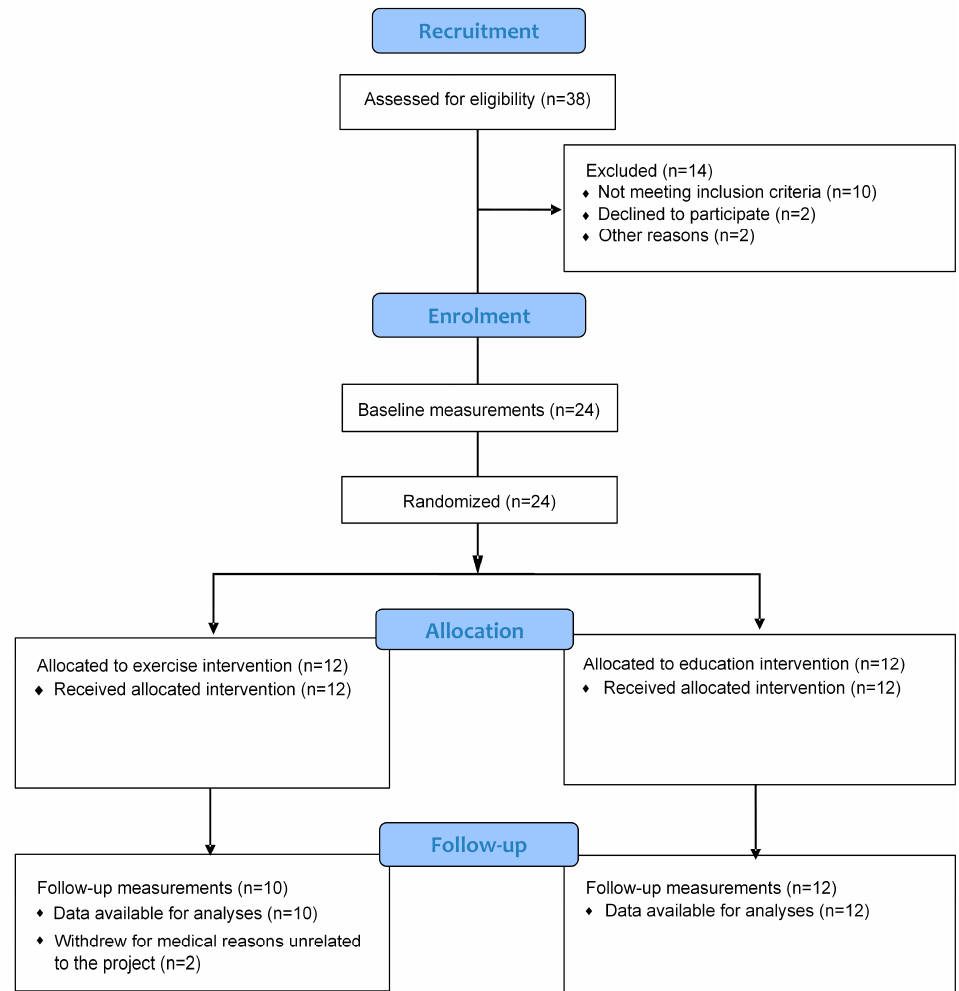
Figure 1. Flow diagram of the progress through the phases of the trial for two groups. Participants in both groups had similar anthropometric and diabetes-related characteristics at baseline (Table 1). MNSI clinical signs score were higher in exercise compared to education ( p = 0.04) indicative of slightly worse baseline peripheral neuropathy in exercise at baseline. Overall, the sample was older (71.1 ± 10.3 years), 54.2% male, 95.8% type 2 diabetes, reported low levels of self-reported exercise (47.8% not adhering to exercise guidelines) and were aerobically unfit (maximum oxygen uptake: 19.8 ± 3.9 mL·kg − 1 ·min − 1 ). Table 1. Participant characteristics at baseline. Variable